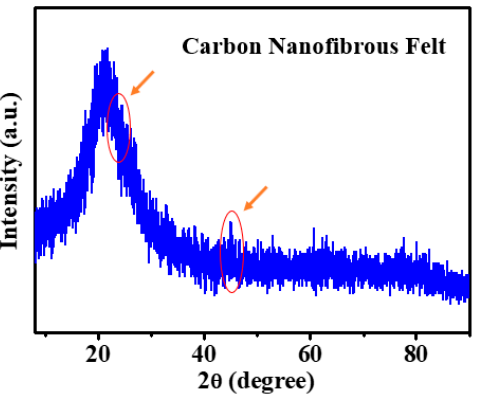
Figure 5. X-ray diffraction (XRD) pattern of the PAN/biochar carbon nanofibrous felt.